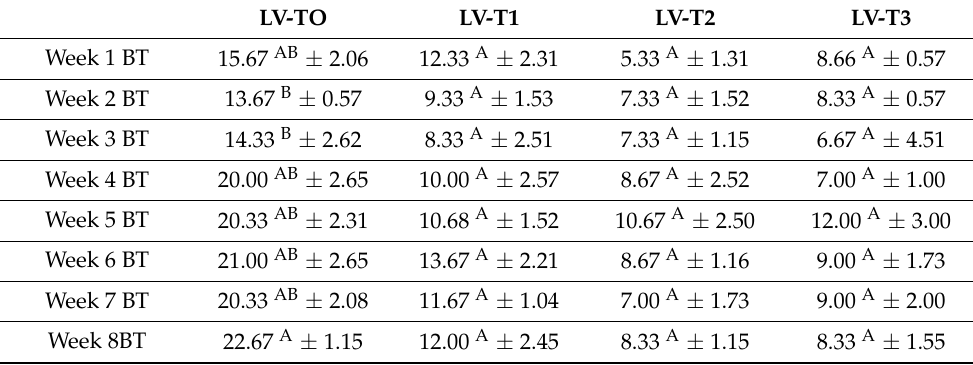
Figure 5. Evolution of the larvae survival of Parlatoria ziziphi according to different follow-up dates after treatment. Table 3. Survival (V) of Parlatoria ziziphi larvae treated with different doses of spirotetramat (T0 = 0 L/ha, T1 = 0.625 L/ha, T2 = 0.755 L/ha, and T3 = 1 L/ha) according to different follow-up dates after